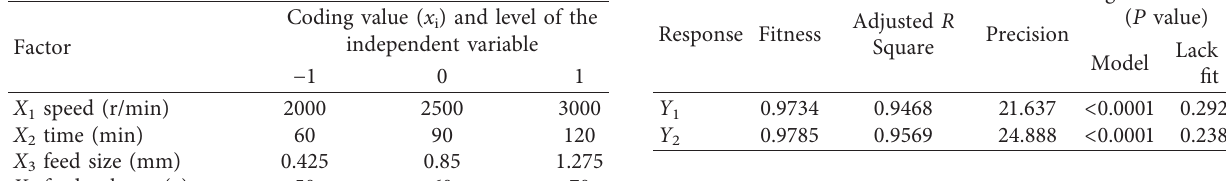
Table 2: Coding and level of the experimental independent variable factor. Coding value ( x i ) and level of the Factor